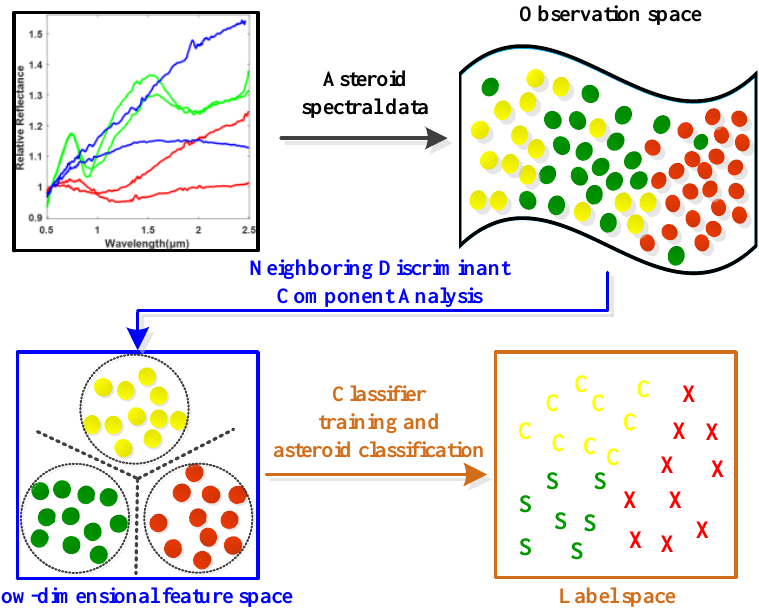
Figure 1. Overview of the asteroid feature learning and classification scheme.